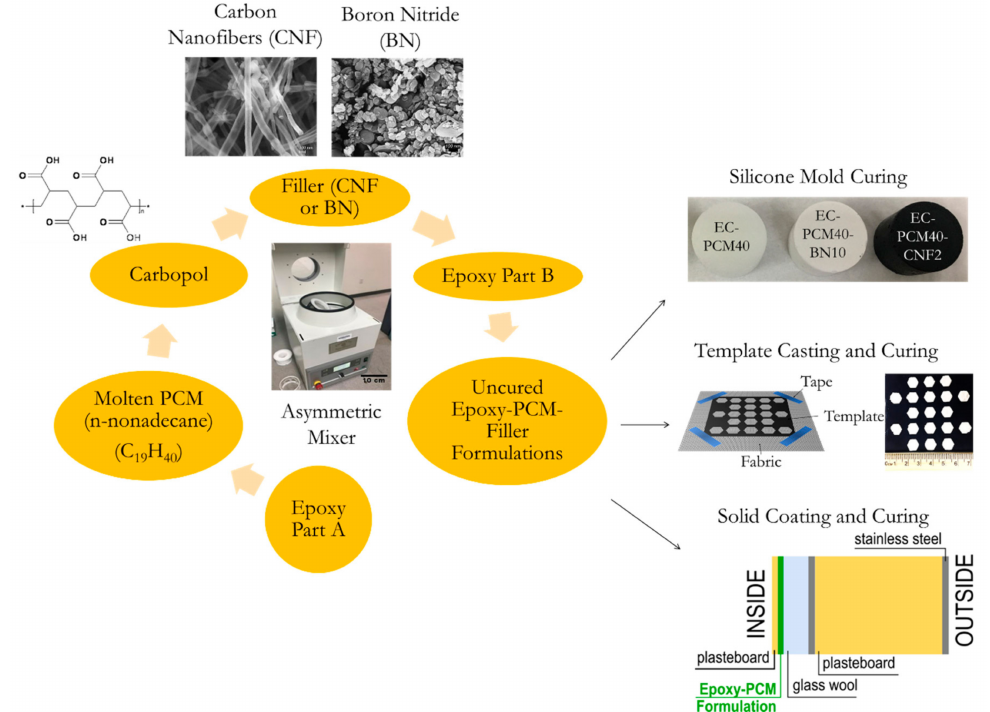
Figure 1. A schematic illustration depicting the process flow for silicone mold cured, template casted, as well as solid-coated epoxy-PCM-filler composite